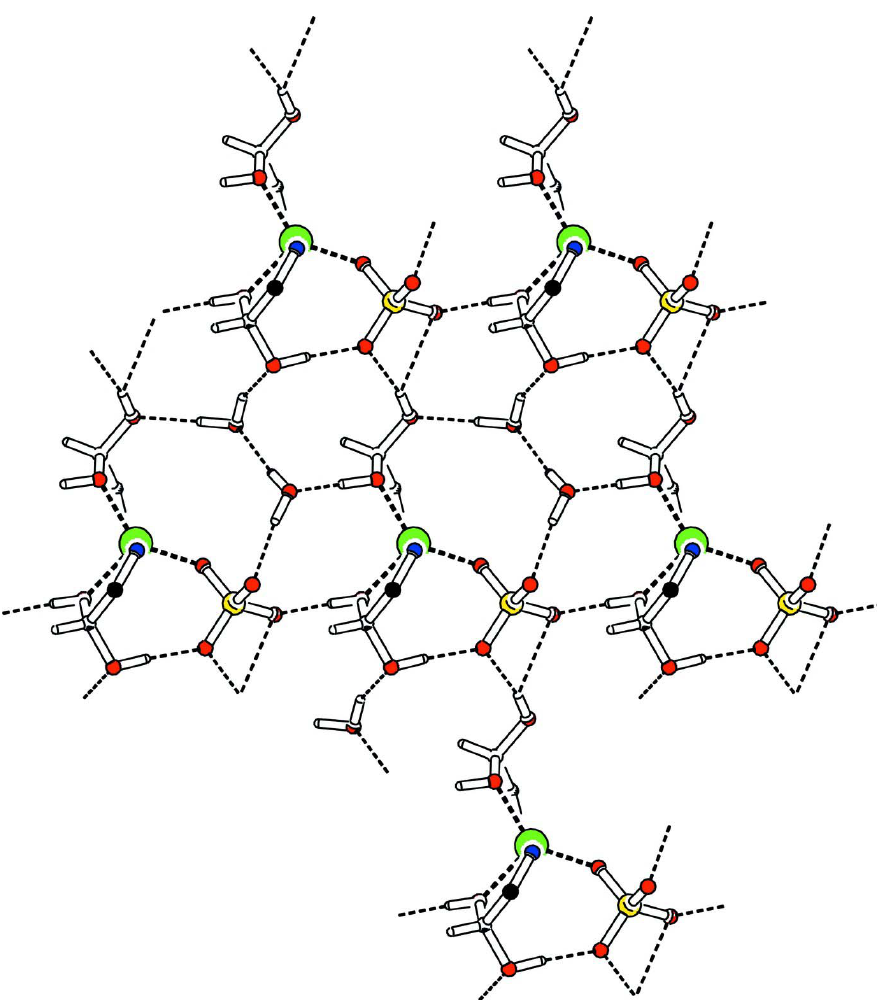
A portion of the H-bond network viewed along the c axis. The hydrohen bonds are depicted as dashed